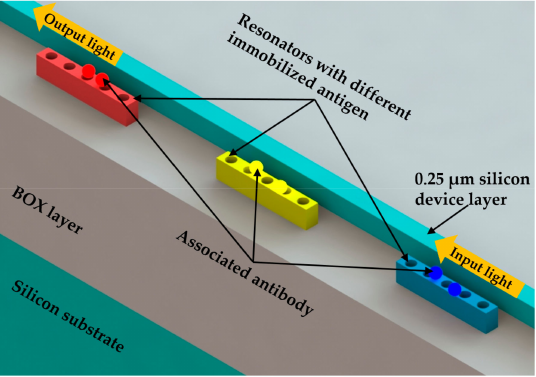
Figure 11. Three waveguide-coupled nanobeam cavities with different immobilized antigens on their